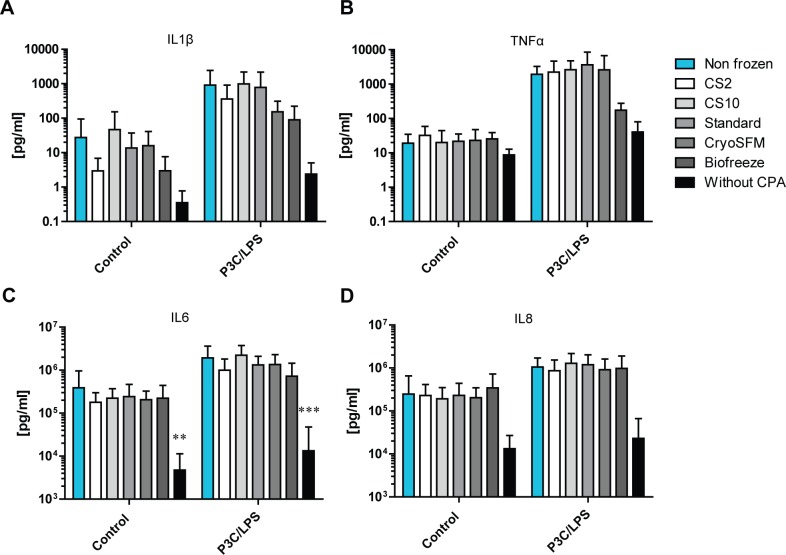
Cryopreserved synovial tissue is responsive to inflammatory stimuli.The secretion of proinflammatory cytokines IL1β (A), TNFα (B), IL6 (C) and IL8 (D) was determined before and after 24 hour stimulation with P3C/LPS. Displayed is the mean +/- SD. Statistical analysis was performed by Students t-test, comparing the unstimulated control to the stimulated conditions. ** p<0.01; *** p<0.001.